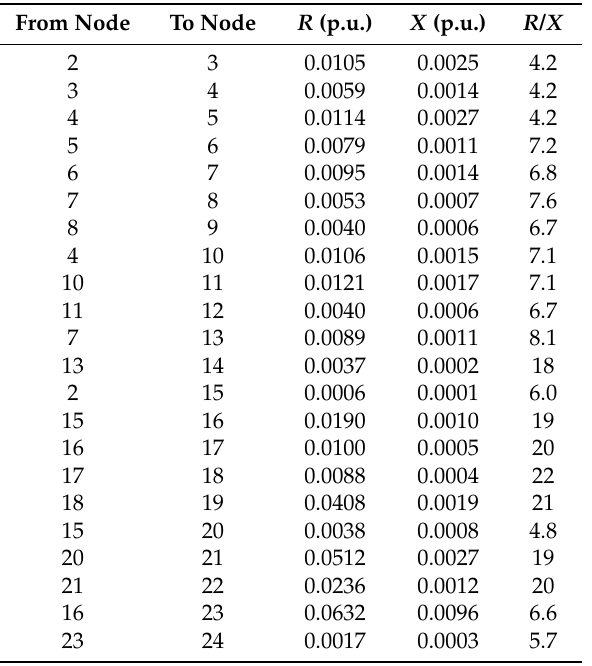
Table 1. Electrical parameters of